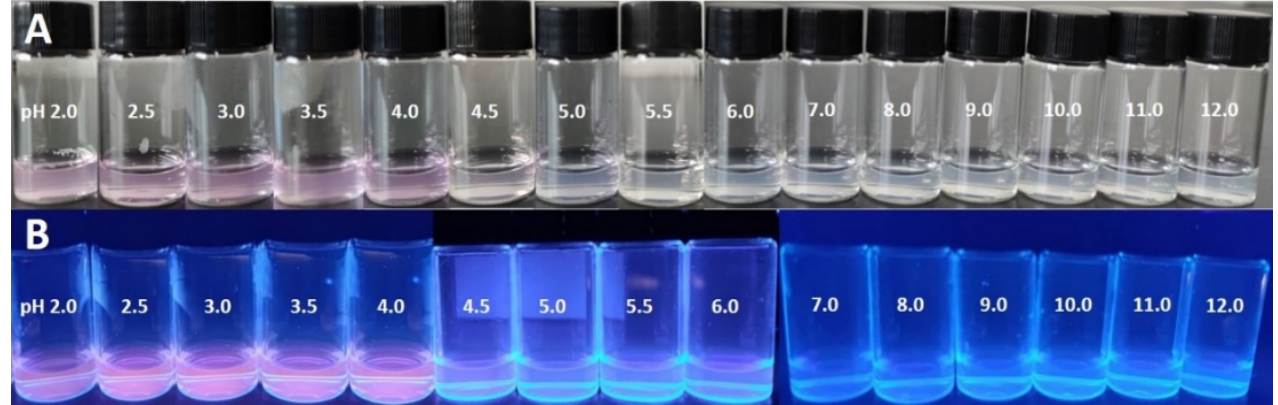
Figure 6. Photographs taken under visible light ( A ) and UV light ( B ) for the micelle solutions of rhodamine-functionalized mPEG-b-P(PA-alt-AGERh) (1.5 mg/mL) at different pH (from left to right: 2.0, 2.5, 3.0, 3.5, 4.0, 4.5, 5.0, 5.5, 6.0, 7.0, 8.0, 9.0, 10.0, 11.0, 12.0).